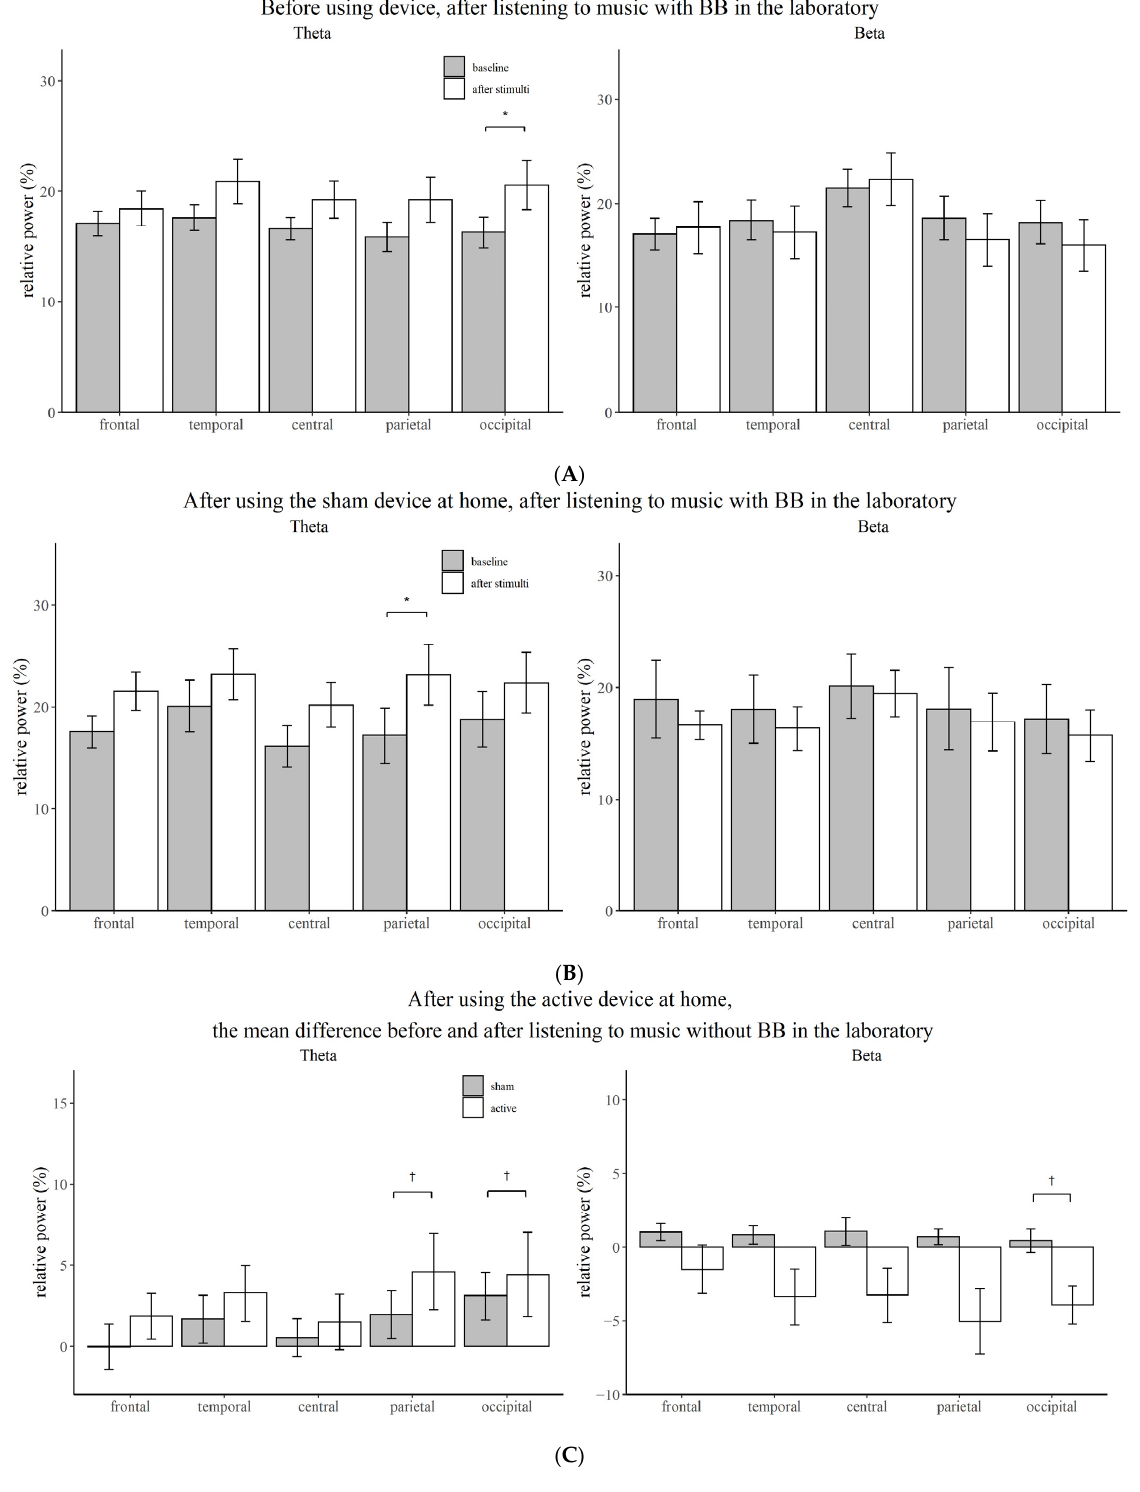
Figure 2. Comparison of the relative power between the baseline state and the state after stimulation for each brain region. ( A ) Before using device, after listening to music with BB in the laboratory. ( B ) After using the sham device at home, after listening to music with BB in the laboratory. ( C ) After using the active device at home, the mean difference before and after listening to music without BB in the laboratory. Vertical bars represent standard deviation; BB, binaural beat; *, Bonferroni corrected p -value < 0.05; †, p -value <